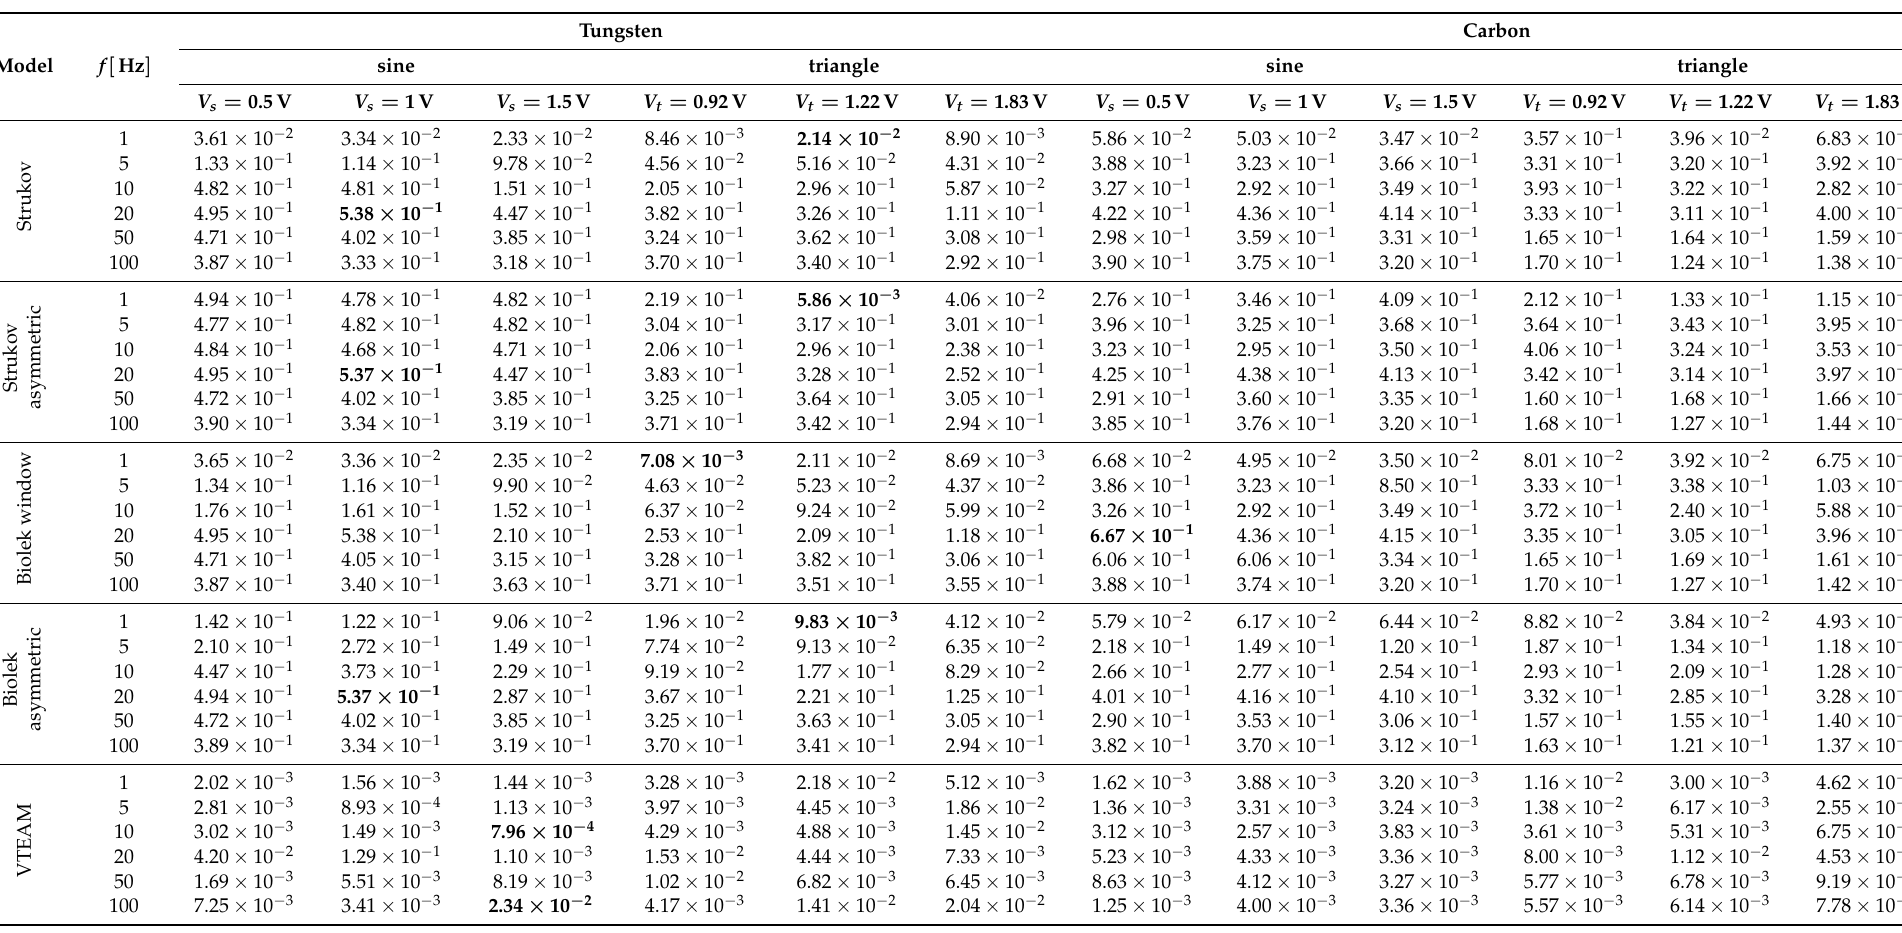
Table 3. The results of the optimization procedure over all models considered. The maximum and minimum values of the cost function for each model are indicated with bold font type.